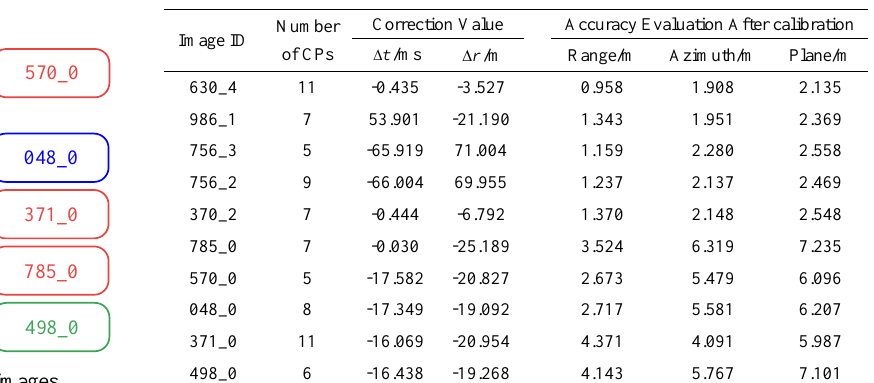
Figure 4. Transfer relation of Table 3. Accuracy evaluation of study images after the geometric calibration